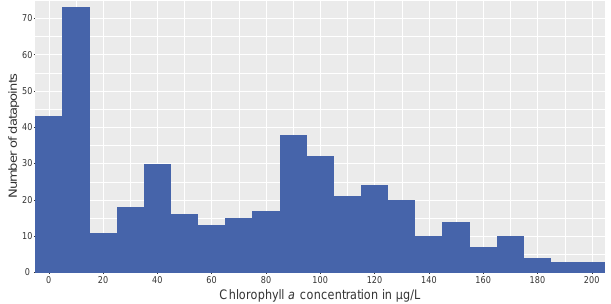
Figure 4. Distribution of the chlorophyll a concentrations in